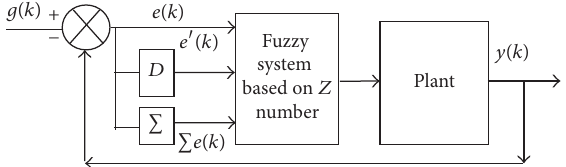
Figure 2: Structure of type-2 FNS based control system.